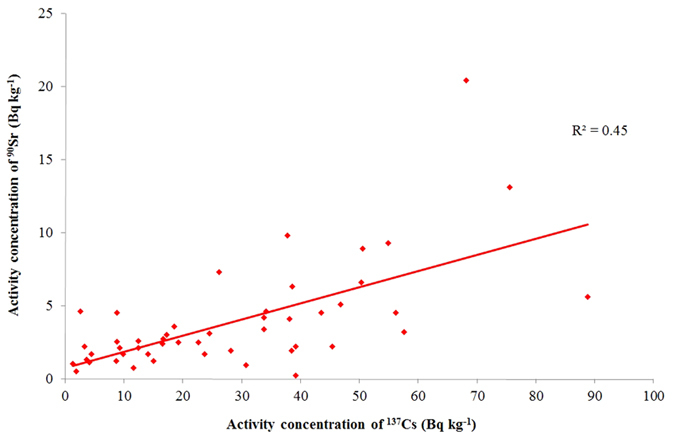
Correlation between 90Sr and 137Cs activity concentration in Fukushima soil samples collected in 2005 (n = 48).